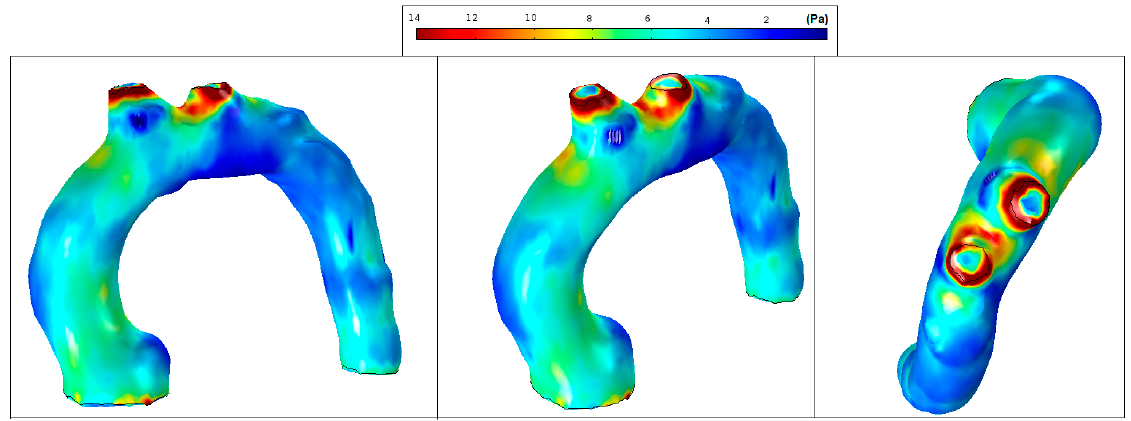
Figure 14. Patient-pilot: wall shear stress (WSS) contours (at peak systole).